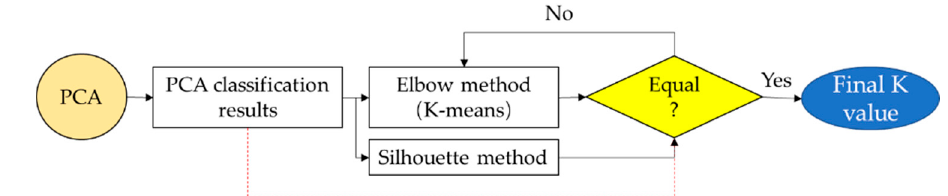
Figure 11. Selection procedure of K value for K-means classification of VE data.